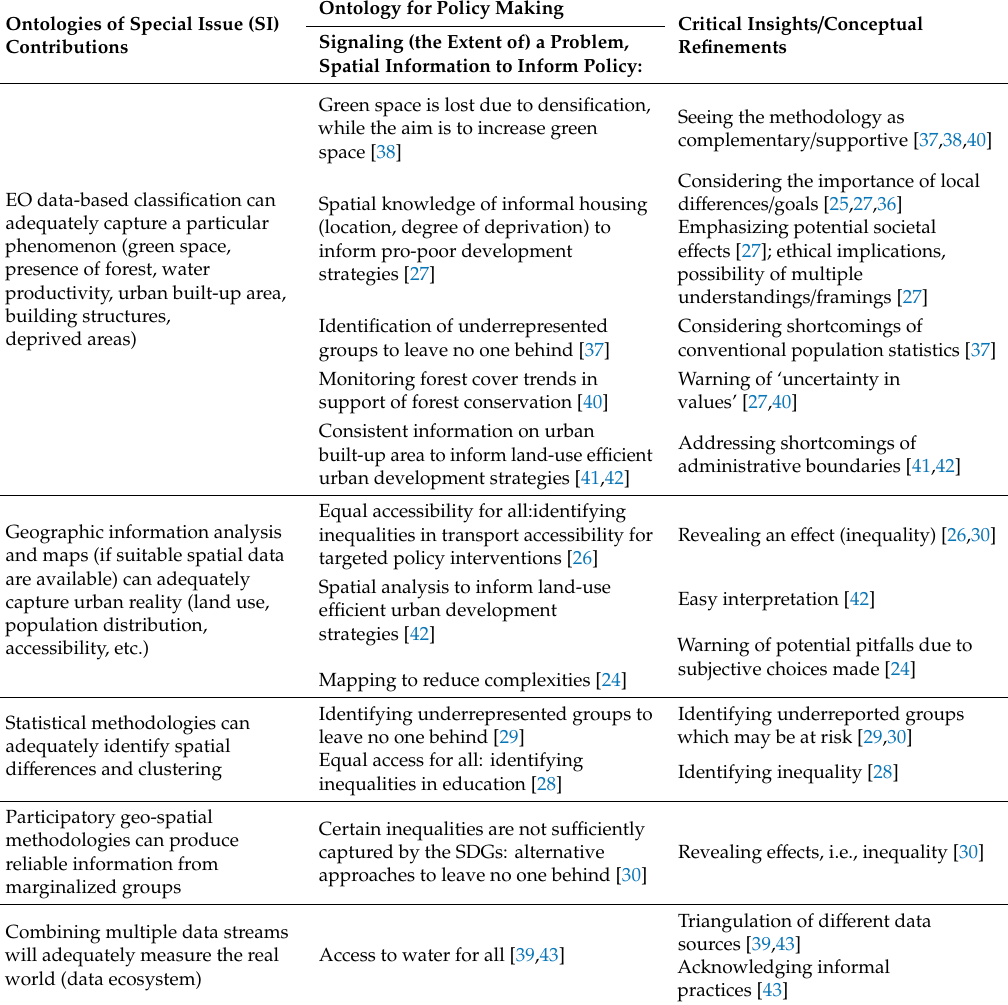
Table 2. Overview of assumptions, policy focus and